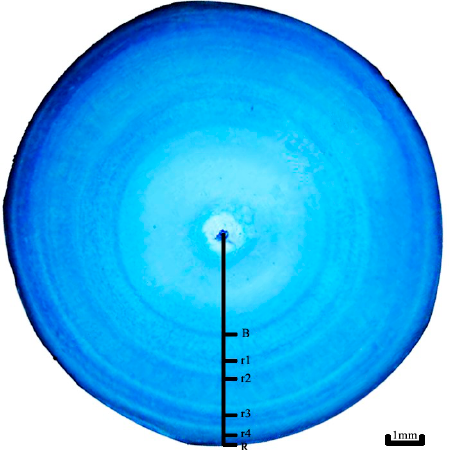
Figure 1. Sampling area of the spot-tail shark in the Taiwan Strait.